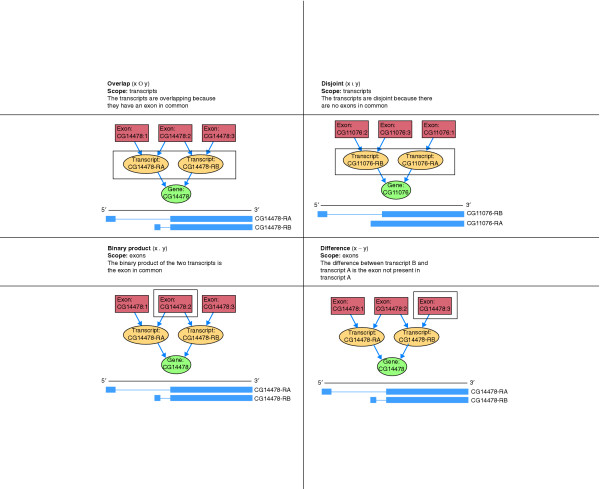
Using EM operations to characterize alternatively spliced transcripts and their exons. The EM operations overlap and disjoint can be used to characterize pair-wise relationships between alternative transcripts. Binary product and difference, on the other hand, pertain to exons shared, or not-shared between two alternative transcripts.